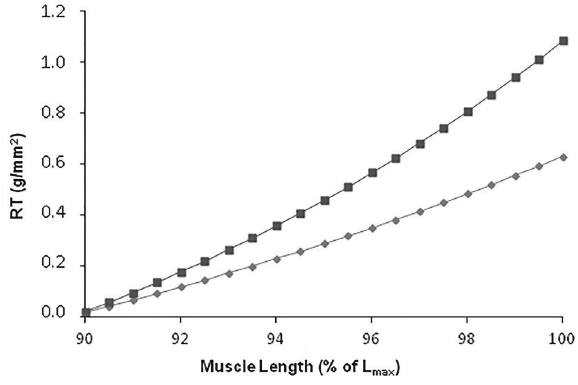
Figure 1. Relationship between muscle length and resting tension (RT) of aortic stenosis (AoS, dark grey, n=32) and control groups (Sham, light grey, n=32), using the progression model adjusted according to groups. Data are reported as mean ± SD. P o 0.05 (non-linear regression model adjustment using the minimum square method).